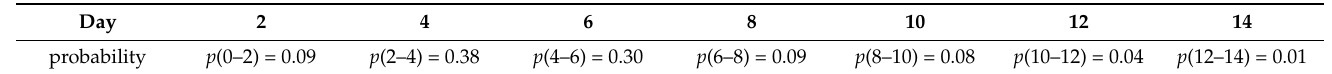
Table A1. Probabilities of infections during quarantine on different days.